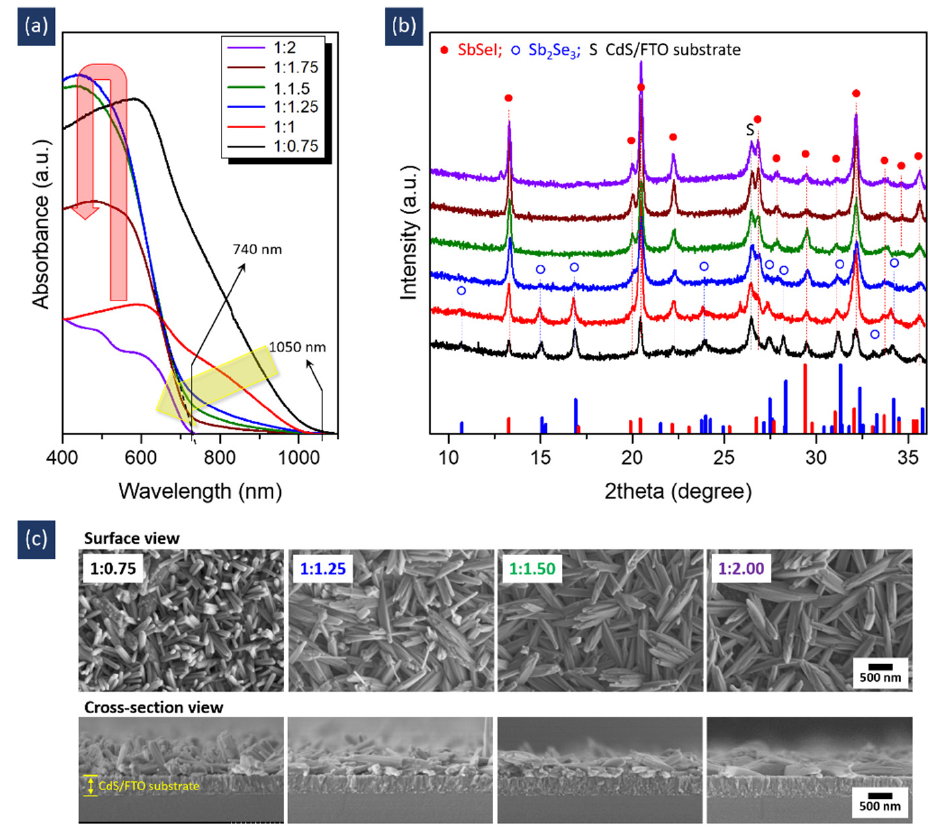
Figure 2. ( a ) Absorption spectra, ( b ) XRD patterns, and ( c ) FESEM images of samples prepared using precursor solutions with different Sol A:Sol B molar ratios. The peak positions of Sb 2 Se 3 and SbSeI are shown in ( b ), based on the reference data of Sb 2 Se 3 (ICDD # 98-065-1518, blue column) and SbSeI (ICDD # 98-003-1292, red column).